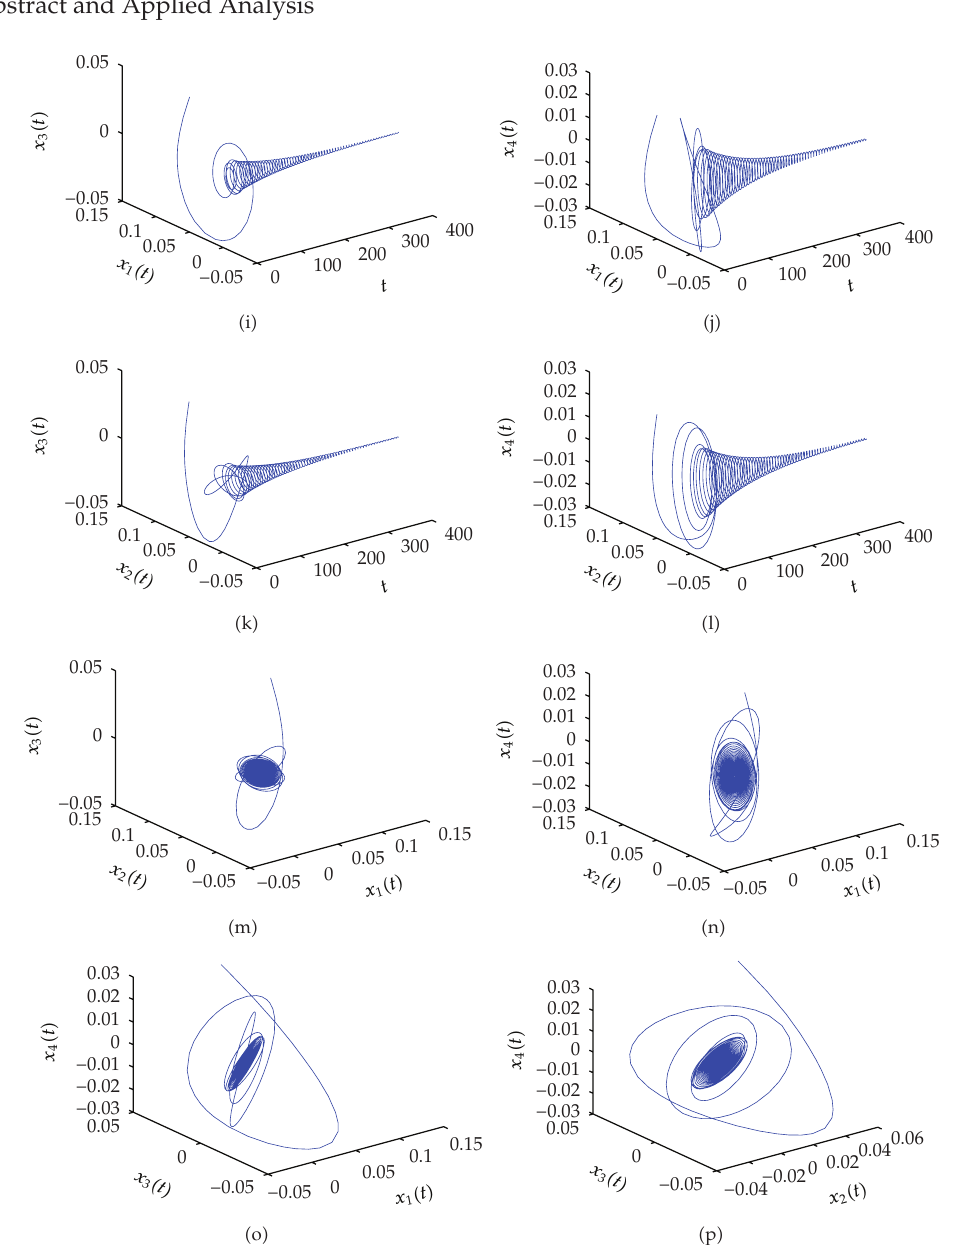
the occurrence of Hopf bifurcation and the oscillatory solutions of the models